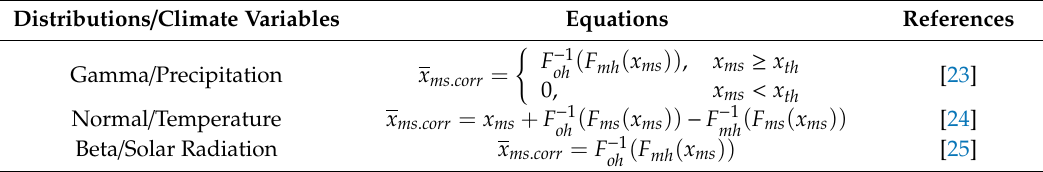
Table 1. Distributions and equations used for bias correction of di ff erent climatic